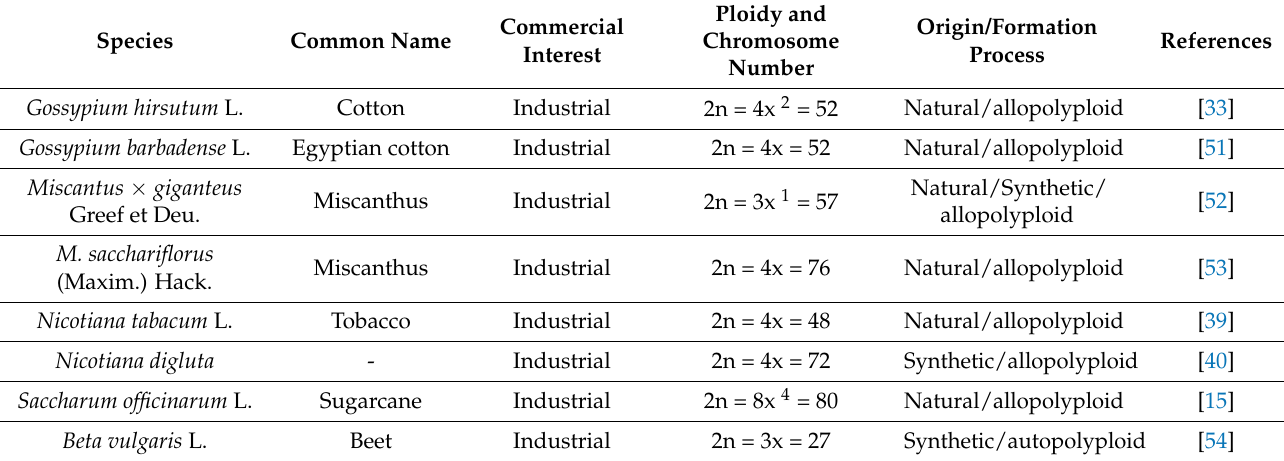
Selected industrial plants and their characterisation regarding their commercial interest, ploidy, origin/formation